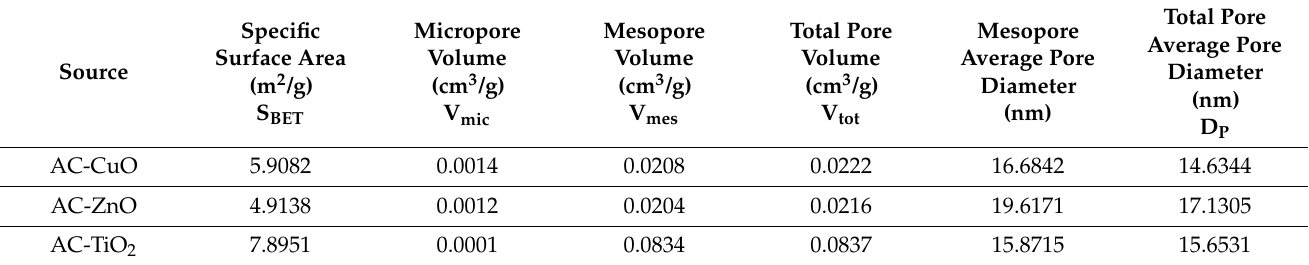
Figure 5. Pore size distribution curves of ( a ) AC-CuO; ( b ) AC-ZnO; and ( c ) AC-TiO 2 . Table 2. Specific surface area and pore volume of the composite